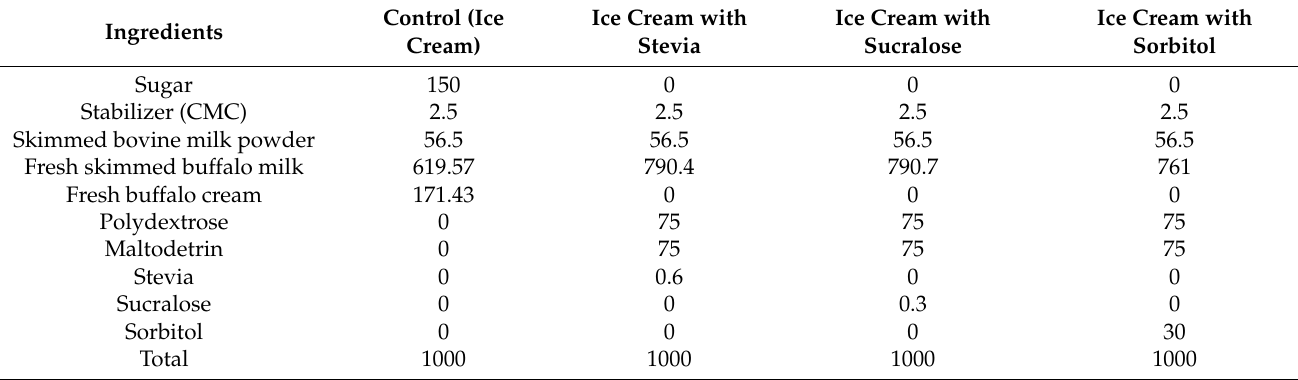
Table 1. Formulation of different incorporated ice cream mixes (g/kg)